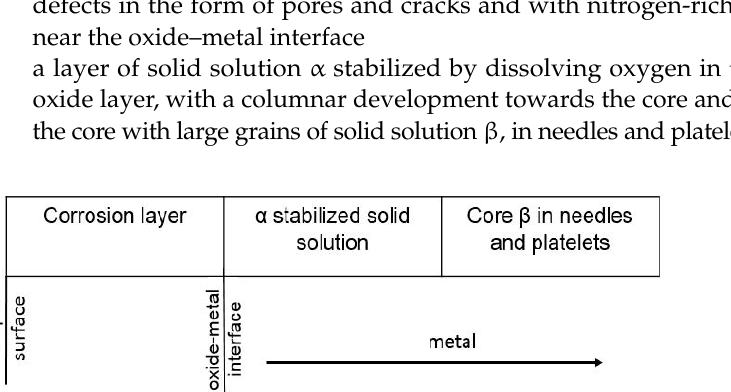
Figure 10. Variation of the thermal diffusivity of the sample during a treatment cycle consisting of heating at 1050 °C and cooling, with maintenance and without maintenance of 30 min at 1050 °C.